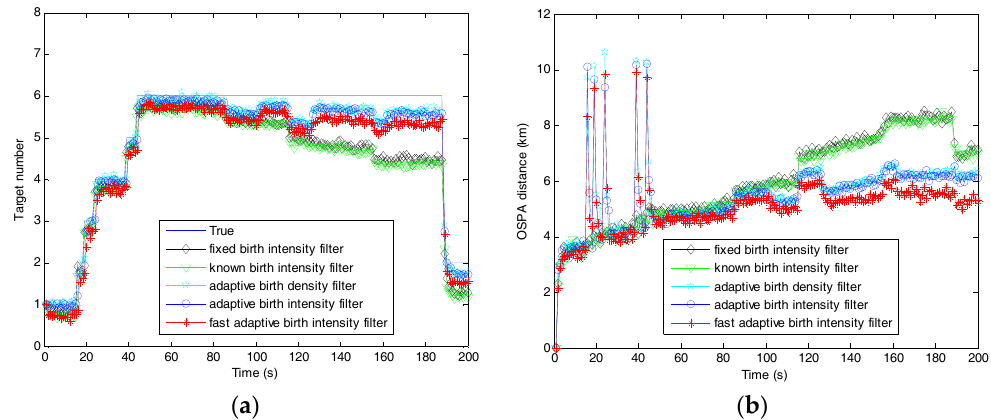
Figure 12. Tracking performance of the fast adaptive target birth intensity CBMeMBer filter and other CBMeMBer filters with different target birth models in the case of unexpected maneuvering: ( a ) target number estimation; ( b ) OSPA distances.